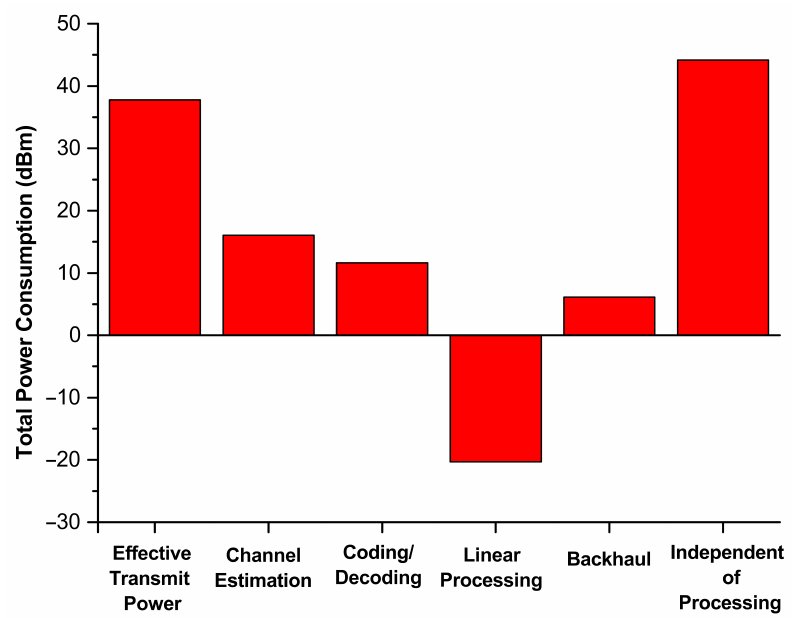
Figure 4. Total power consumption of the proposed network design. Using the proposed power consumption model and the evaluated area throughput, the system energy efficiency is calculated. To validate the numerical analysis done in Sections 2 and 3, Figure 5 shows the energy efficiency of the proposed network design as a function of AP density. The energy efficiency increases with the increase in AP density until it reaches maximum value at a particular point; after, that the value saturates. The performance of PMMSE, PRZF and MR suggests that the optimal value of energy efficiency in all the three schemes is obtained at the same AP density. With PMMSE, the EE achieved is 5.2362 Mbit/Joule with 29 APs deployed in a given coverage area, while MR combining provides 3.0404 Mbit/Joule at the same AP density. The PRZF method improves the optimal EE by 40.7% over the MR scheme with the same AP deployment. The optimal EEs for the three schemes are shown in Figure 6. To show the variation of energy efficiency with the average area throughput, EE is plotted against the area throughput in Figure 7. It is clear from the figure that the energy efficiency and area throughput can be jointly increased until maximum EE is reached at a point. After that point, increasing the area throughput will lead to a decrease in energy efficiency. At the area throughput of 2.2603 Gbit/s/km 2 , the maximum EE of 5.0595 Mbit/Joule is achieved with PMMSE combiner. The PRZF method reduces the maximum EE by 22.3% to achieve the same area